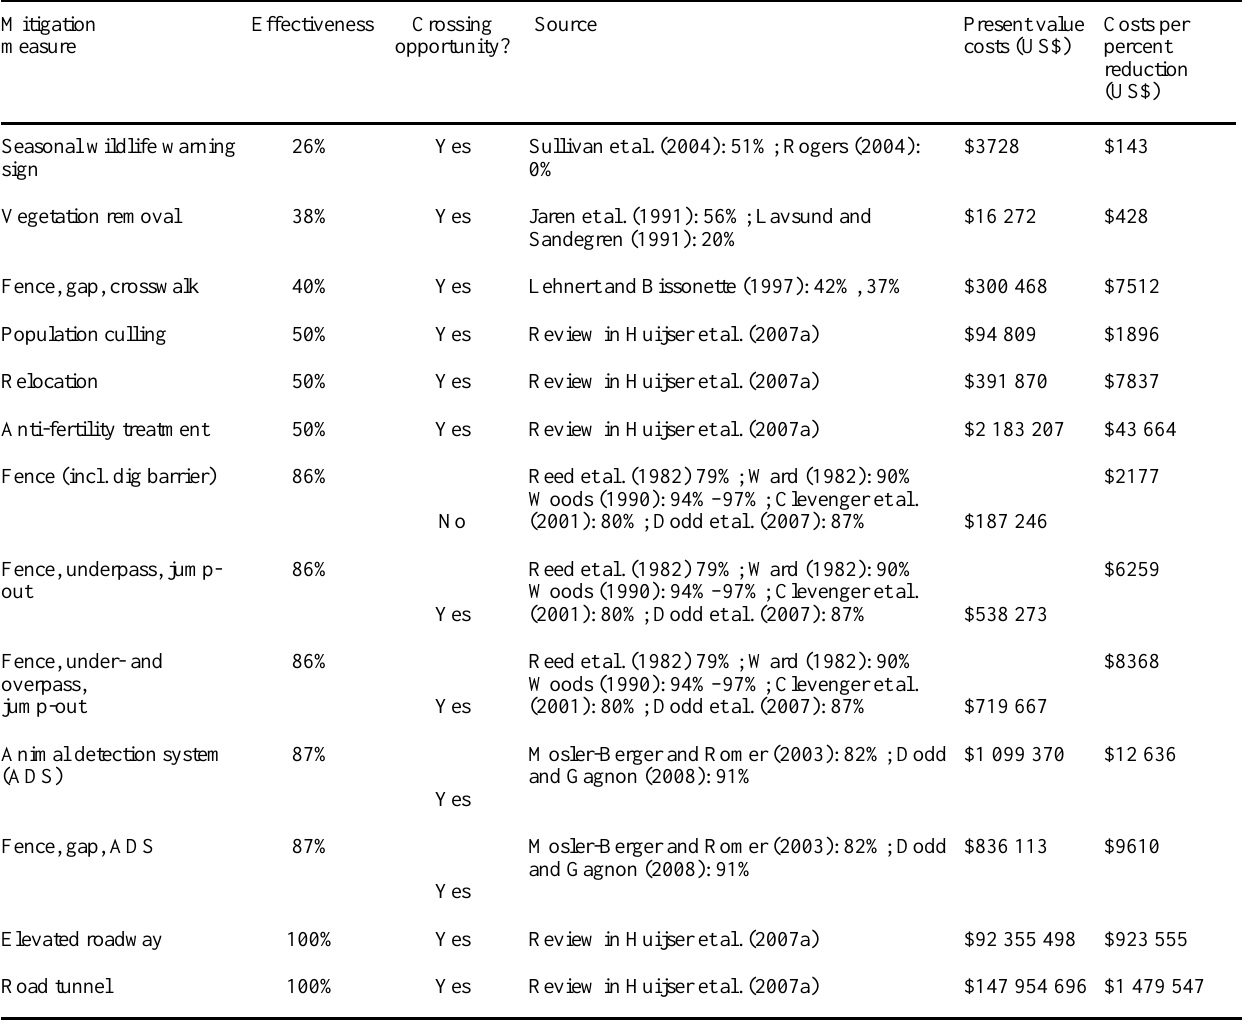
Table 1. The estimated effectiveness, present value costs (in 2007 US$, 3% discount rate), and costs per percent reduction of mitigation measures aimed at reducing collisions with large ungulates over a 75-year time period. The measures are ordered based on their estimated effectiveness. If a measure is estimated to be 86% effective, it means that ungulate–vehicle collisions are estimated to reduce by 86% as a result of the implementation of that mitigation measure (e.g., a reduction from 100 collisions to 14